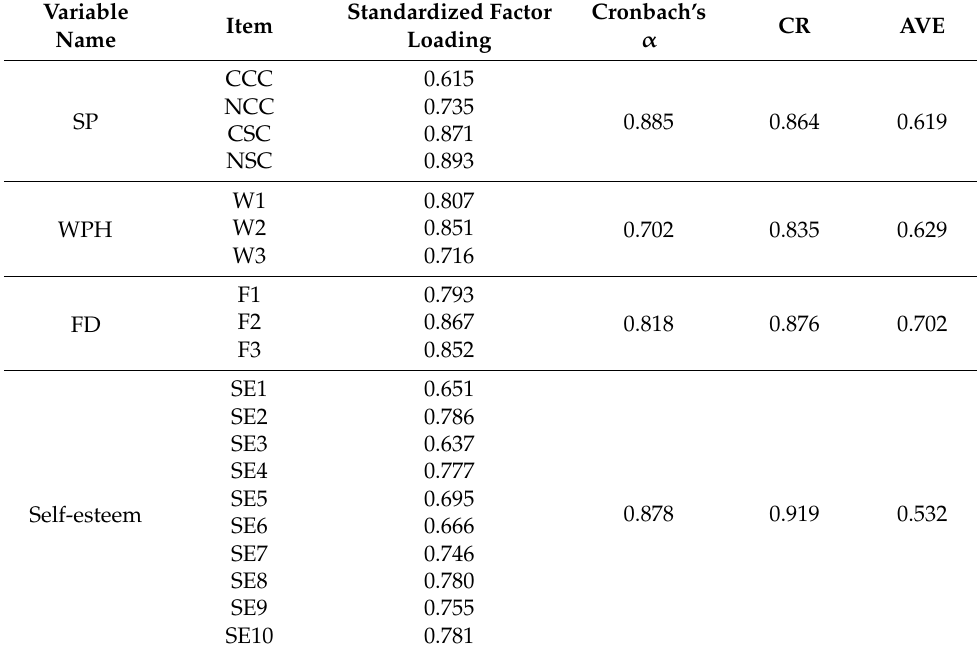
Table 1. Reliability and validity analysis ( n =